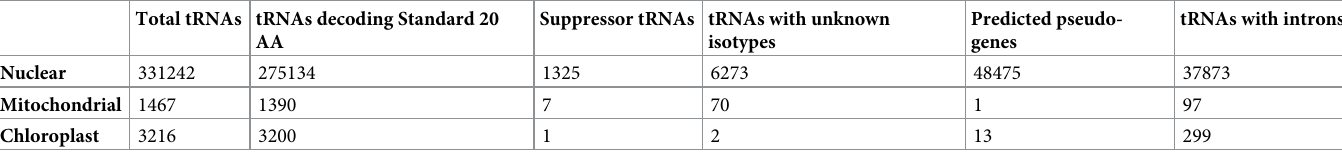
Table 3. Total numbers of tRNAs, the tRNAs decoding 20 standard amino acids, suppressor tRNAs (TTA, CTA, TCA), tRNAs with unknown isotypes, predicted pseudo-genes, and tRNAs with introns for the nuclear, chloroplast and mitochondrial genomes. Total tRNAs tRNAs decoding Standard 20